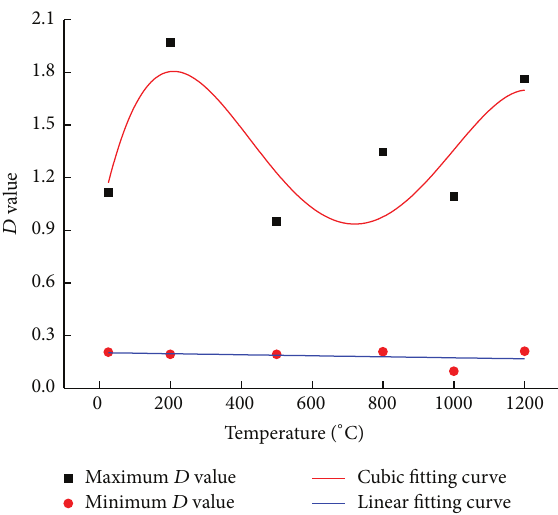
Figure 10: Variation of the CFD with increasing stress level after different heat temperature.